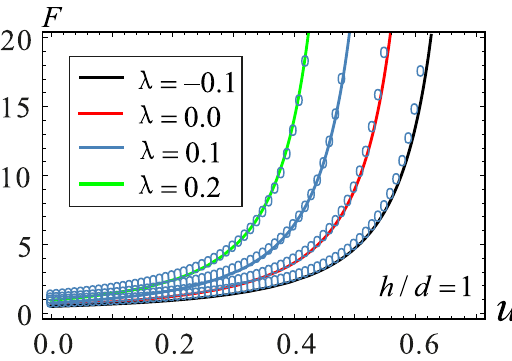
Figure 2. Contrast diagram of fitting curves under different section parameters. The circle is calculated using the numerical solution. The line is calculated using the Newton–Cotes method.